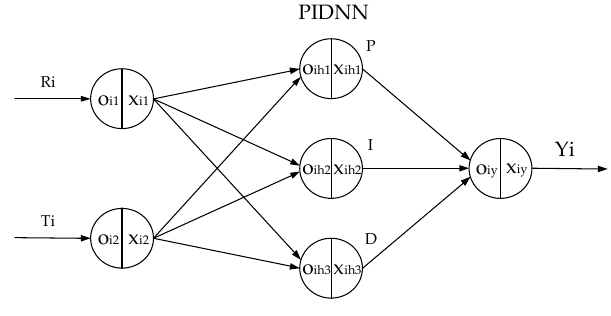
Figure 2. Structure of the PIDNN.